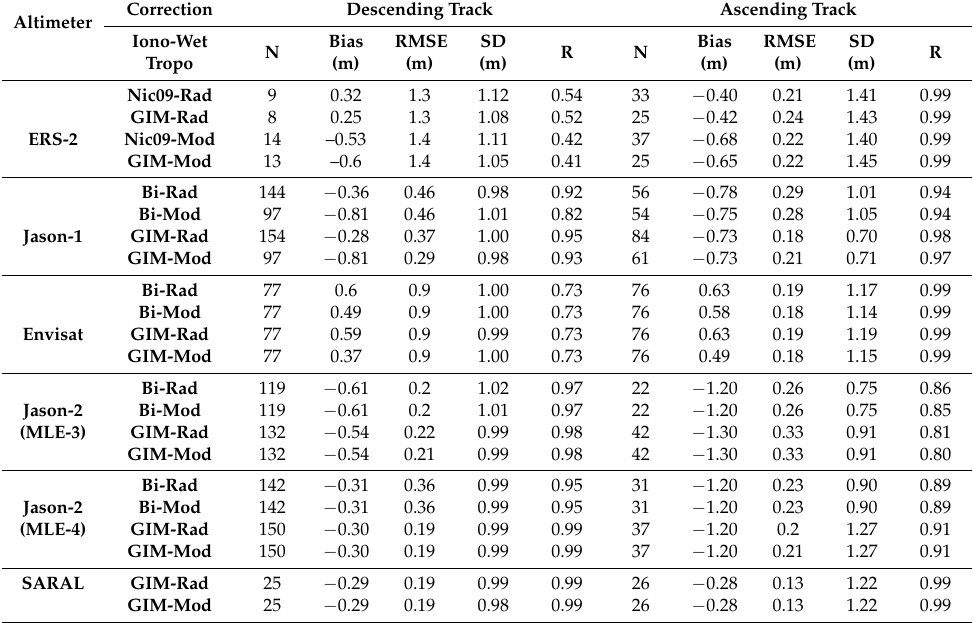
Table 4. Comparisons between altimetry-based SSH and in-situ SSH in La Rochelle from zero to five kilometers away from the coast (N, bias, RMSE, SD, and R) for ascending and descending tracks of sERS-2, Jason-1, Jason-2, Envisat, and SARAL satellites, and for various ionospheric and tropospheric corrections including GIM, bi-frequency, and model-based wet